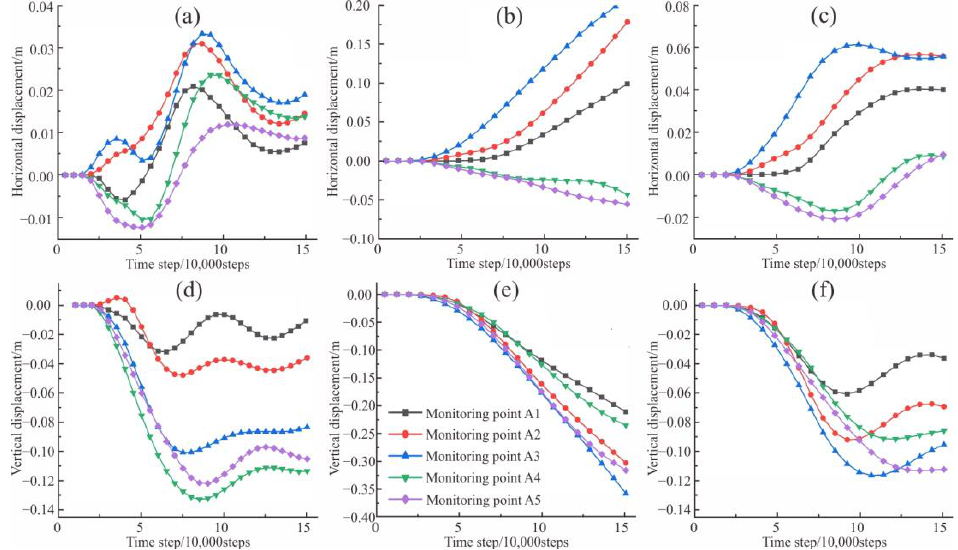
Figure 7. Displacement curves of the monitoring points on the ground. ( a ) Horizontal displacement under the condition of backfill mining without fissures; ( b ) horizontal displacement under the condition of mining with fissures; ( c ) horizontal displacement under the condition of backfill mining with fissures; ( d ) vertical displacement under the condition of backfill mining without fissures; ( e ) vertical displacement under the condition of mining with fissures; and ( f ) vertical displacement under the condition of backfill mining with fissures.